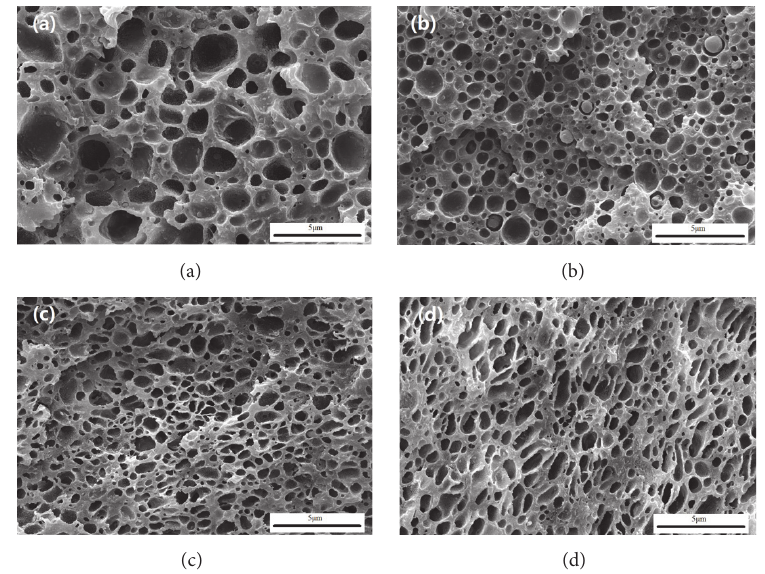
Figure 4: SEM micrographs of PPO/PA66 blends and nanocomposites: (a) T; (b) N-2; (c) N-4; (d) N-6.